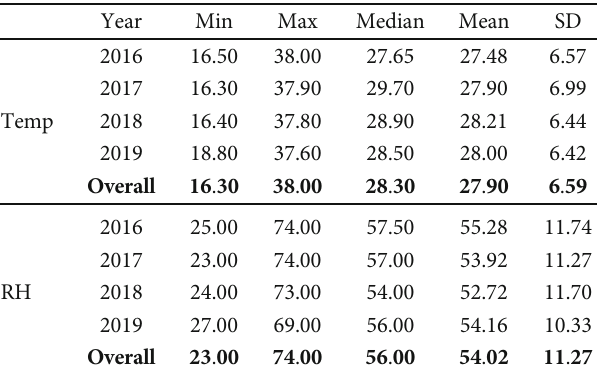
Table 2: Summary statistics of the available temperature in Celsius, and relative humidity measured at 9 monitoring sites in Qatar; SD stands for standard